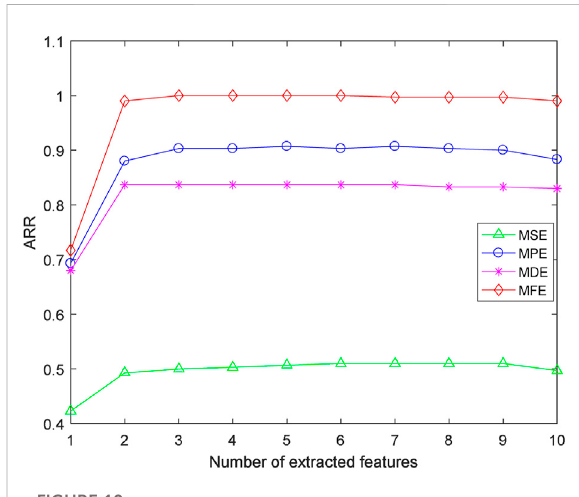
FIGURE 10 Highest ARR of four types of entropies for six SRNs.